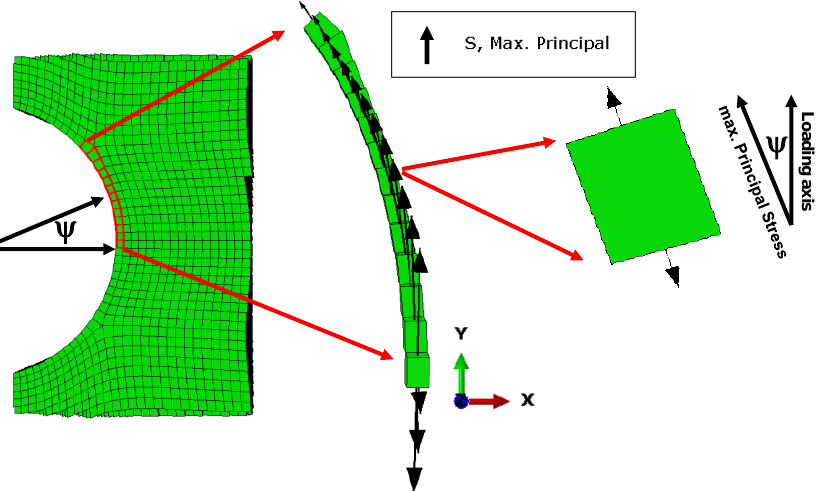
Figure 15. Directions of maximum principle stress along the notch compared to loading direction y.